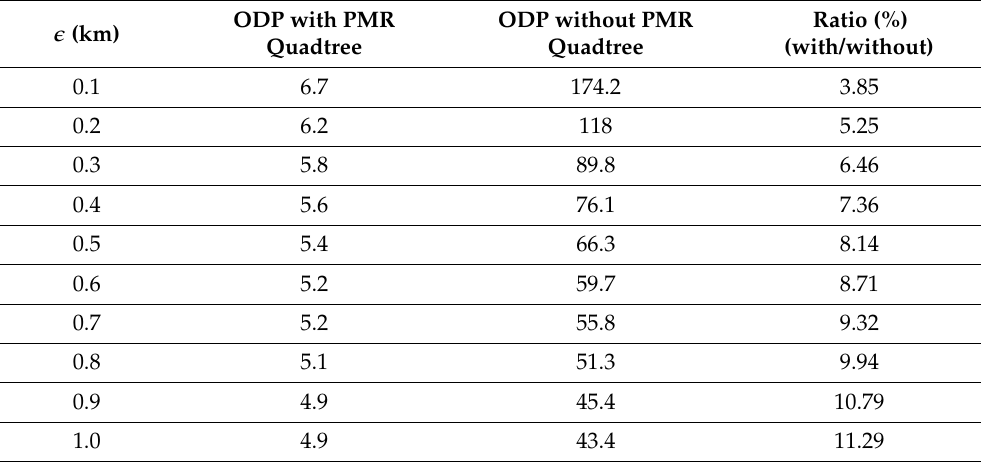
Table 7. Comparison of the computational efficiencies of the ODP algorithms with and without the PMR quadtree (Trajectory